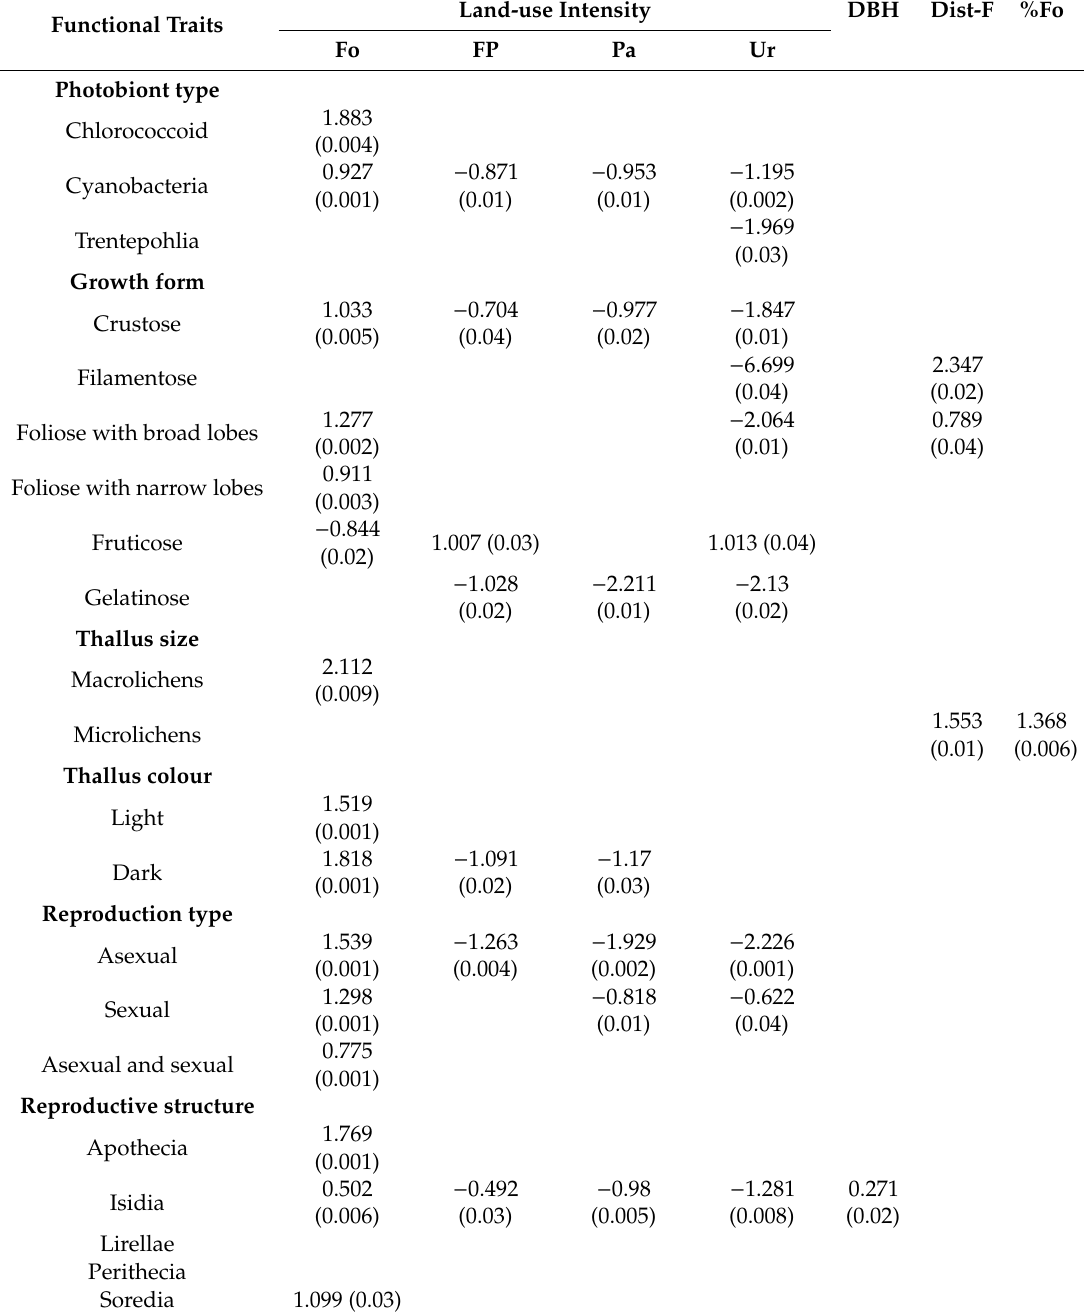
Table 4. Summary of the GLMM applied on the functional traits of the epiphytic lichen community in four riparian land uses of Andean streams in southern Ecuador. Coe ffi cient of variation with di ff erences at p -value ( < 0.05) are indicated in brackets. DBH: diameter at breast height. Fo = Forest; FP = Forest-Pasture; Pa = Pasture; y Ur = Urban. DBH = diameter at breast height, Dist-F = distance to forest; %Fo = percentage of